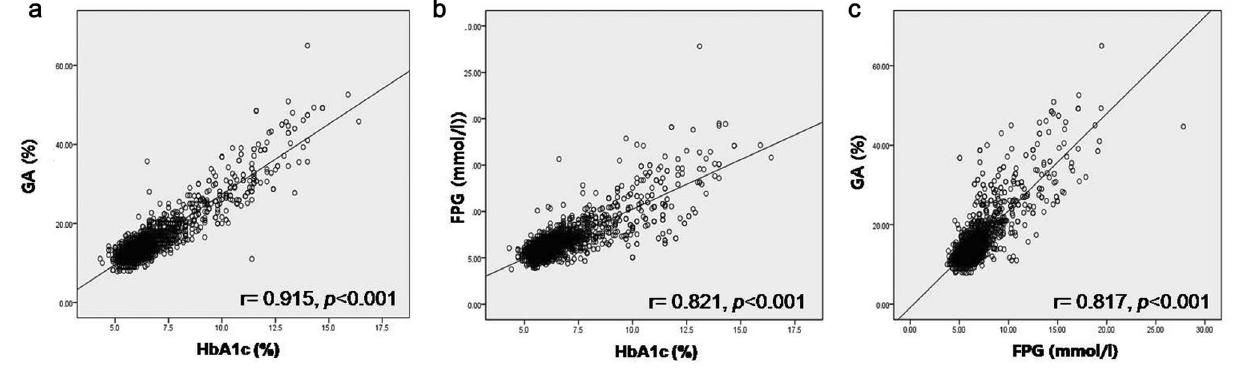
Figure 2. Correlation between HbA1c and GA (A), FPG and HbA1c (B), and FPG and GA (C). doi:10.1371/journal.pone.0095729.g002 PLOS ONE |